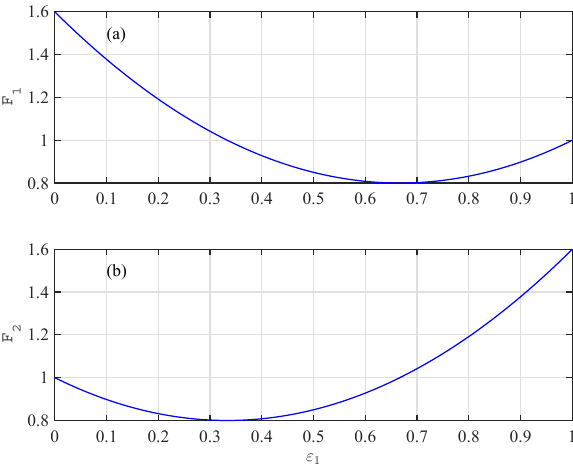
Figure 3. Approximation to the quadratic velocity u | u | by the Chebyshev polynomials approach for the case of two tidal con- stituents (i.e., M 2 and K 1 ). Here, u = 0 . 6cos (ω 1 t) + 0 . 2cos (ω 2 t) , where ω 1 and ω 2 represent the tidal frequencies of M 2 and K 1 , re- spectively.